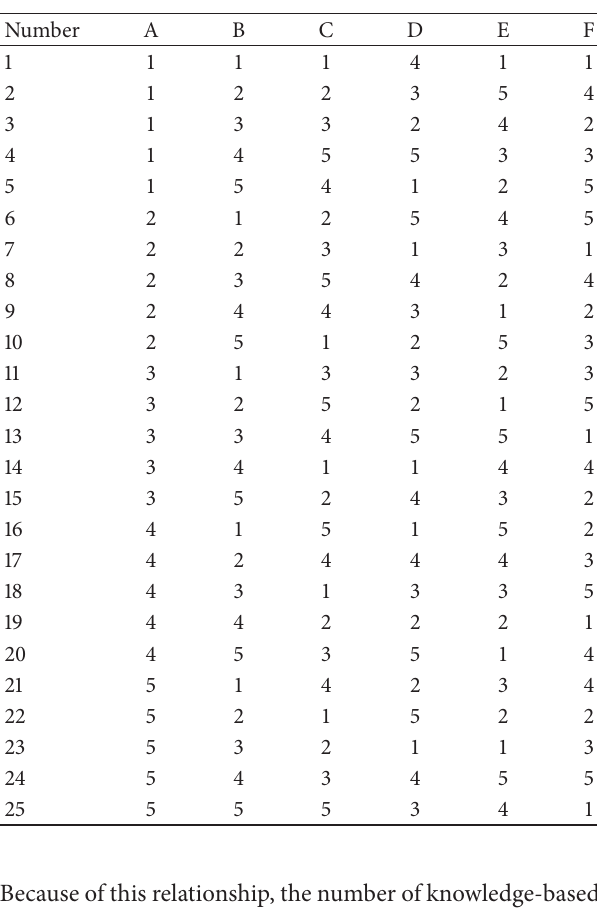
Table 1: Orthogonal table with 6 factors and 5